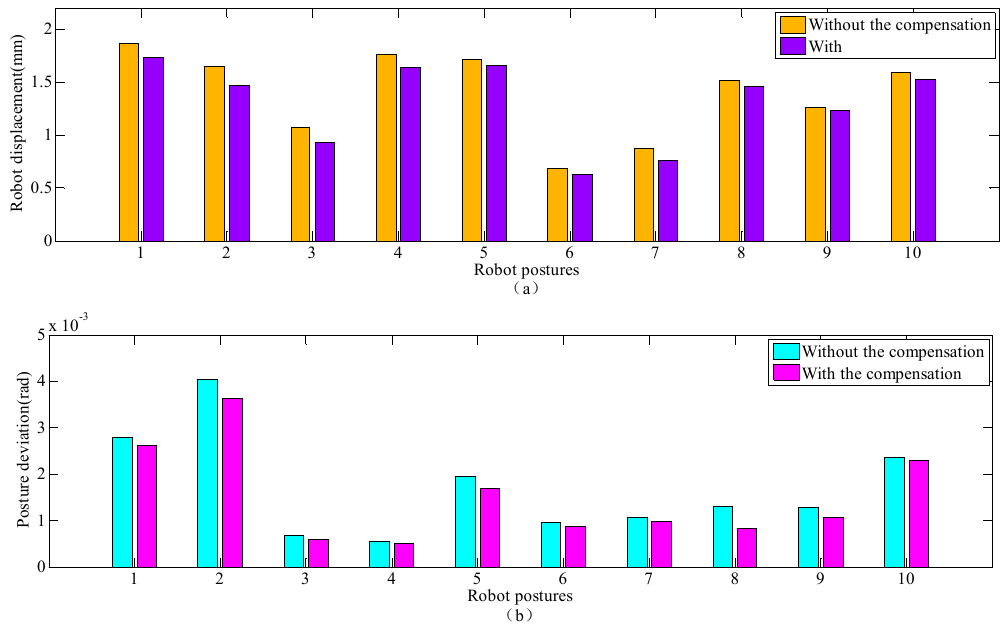
Figure 8. The pose deviation of R2. ( a ) With the compensation; ( b ) Without the compensation.